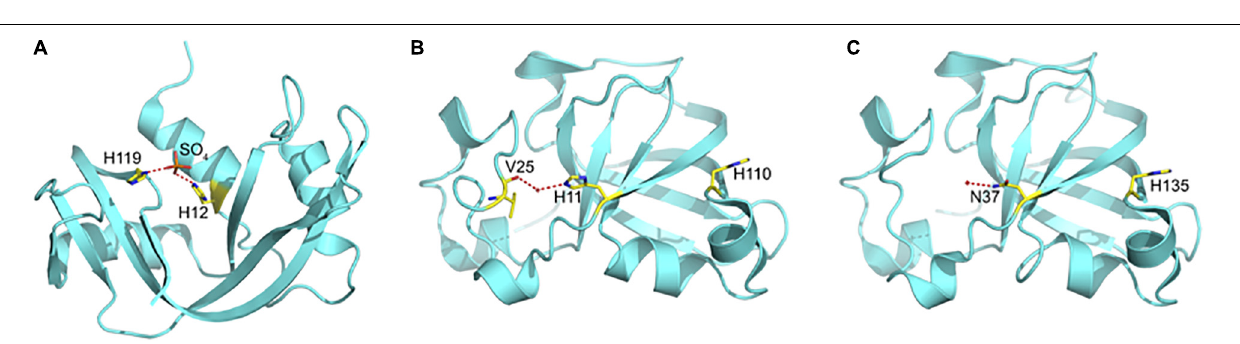
FIGURE 2 | Crystallographic structure of SUGARWIN2. The structure of SUGARWIN2 at 1.55 Å shown in cartoon-style using the “Chainbow” representation in which the N-terminus is dark blue and the C-terminus red. SUGARWIN2 has the classical BARWIN-like fold. The variable loop between the first and second β -strands (blue and green respectively) is two residues shorter than in previously reported structures.